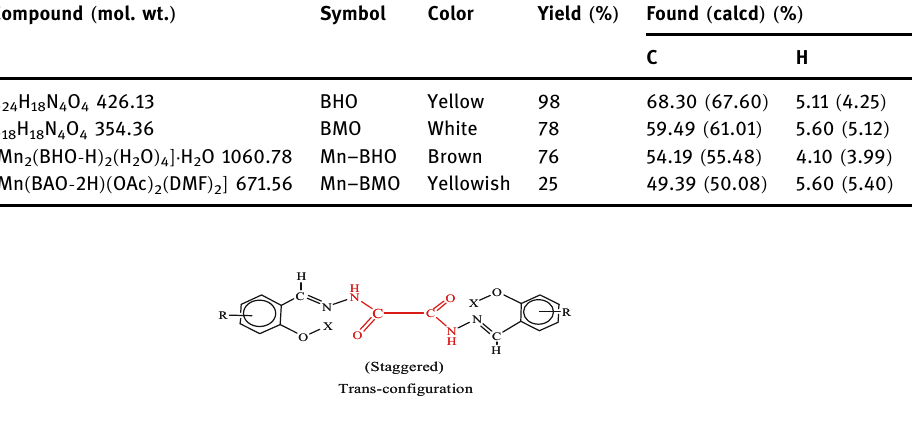
Table 1: Analytical and physical data of the ligands and their related Mn ( II ) complexes Compound ( mol. wt.